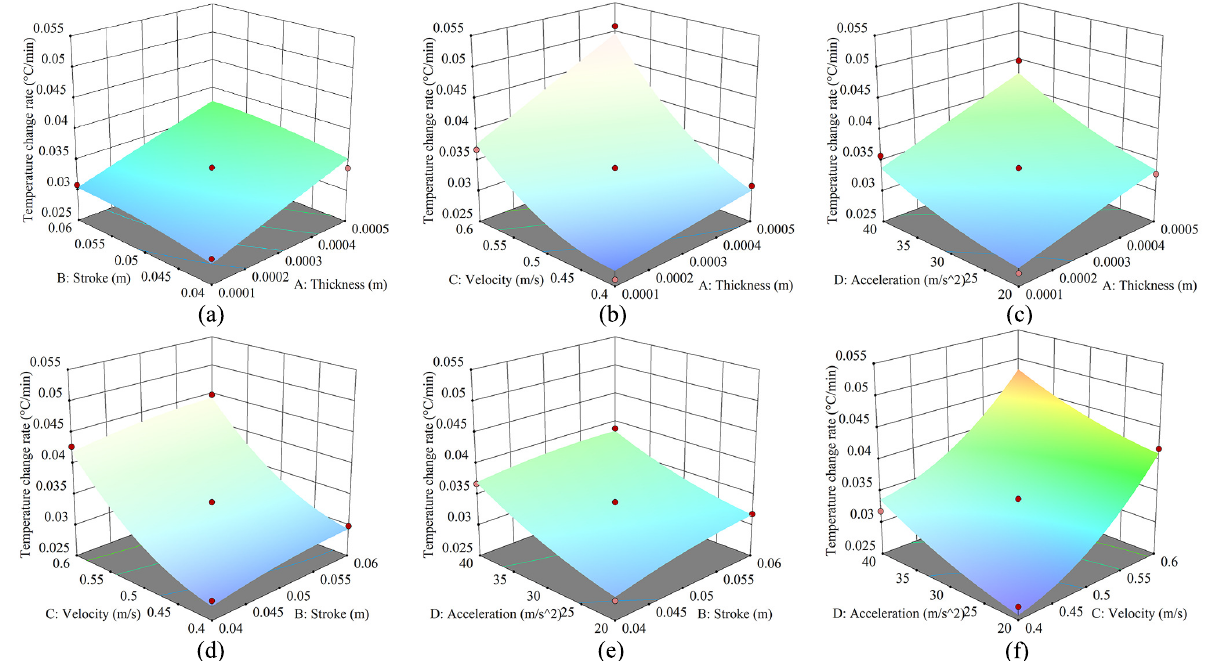
Figure 10. ( a ) Response surface plot for κ under different thicknesses and strokes; ( b ) Response surface plot for κ under different thicknesses and velocities; ( c ) Response surface plot for κ under different thicknesses and accelerations; ( d ) Response surface plot for κ under different strokes and velocities; ( e ) Response surface plot for κ under different strokes and accelerations; ( f ) Response surface plot for κ under different velocities and